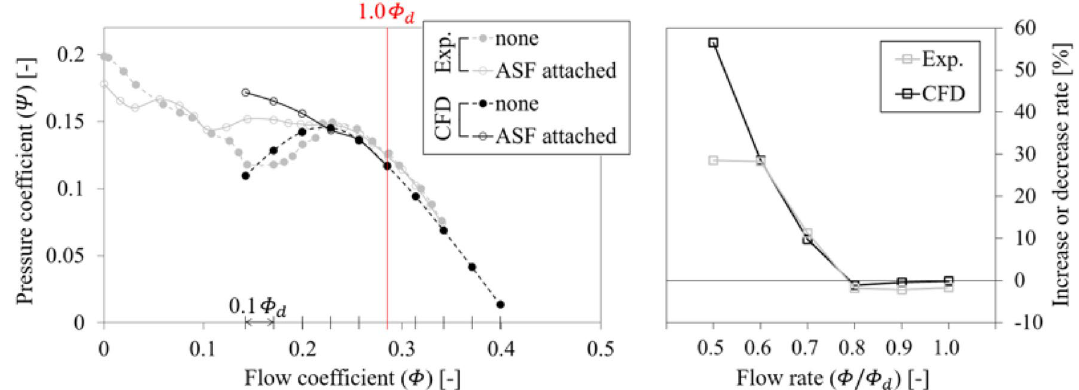
Figure 7. Q – P curve for each case of none and ASF attached (left) and increase or decrease rate of total pressure rise with ASF